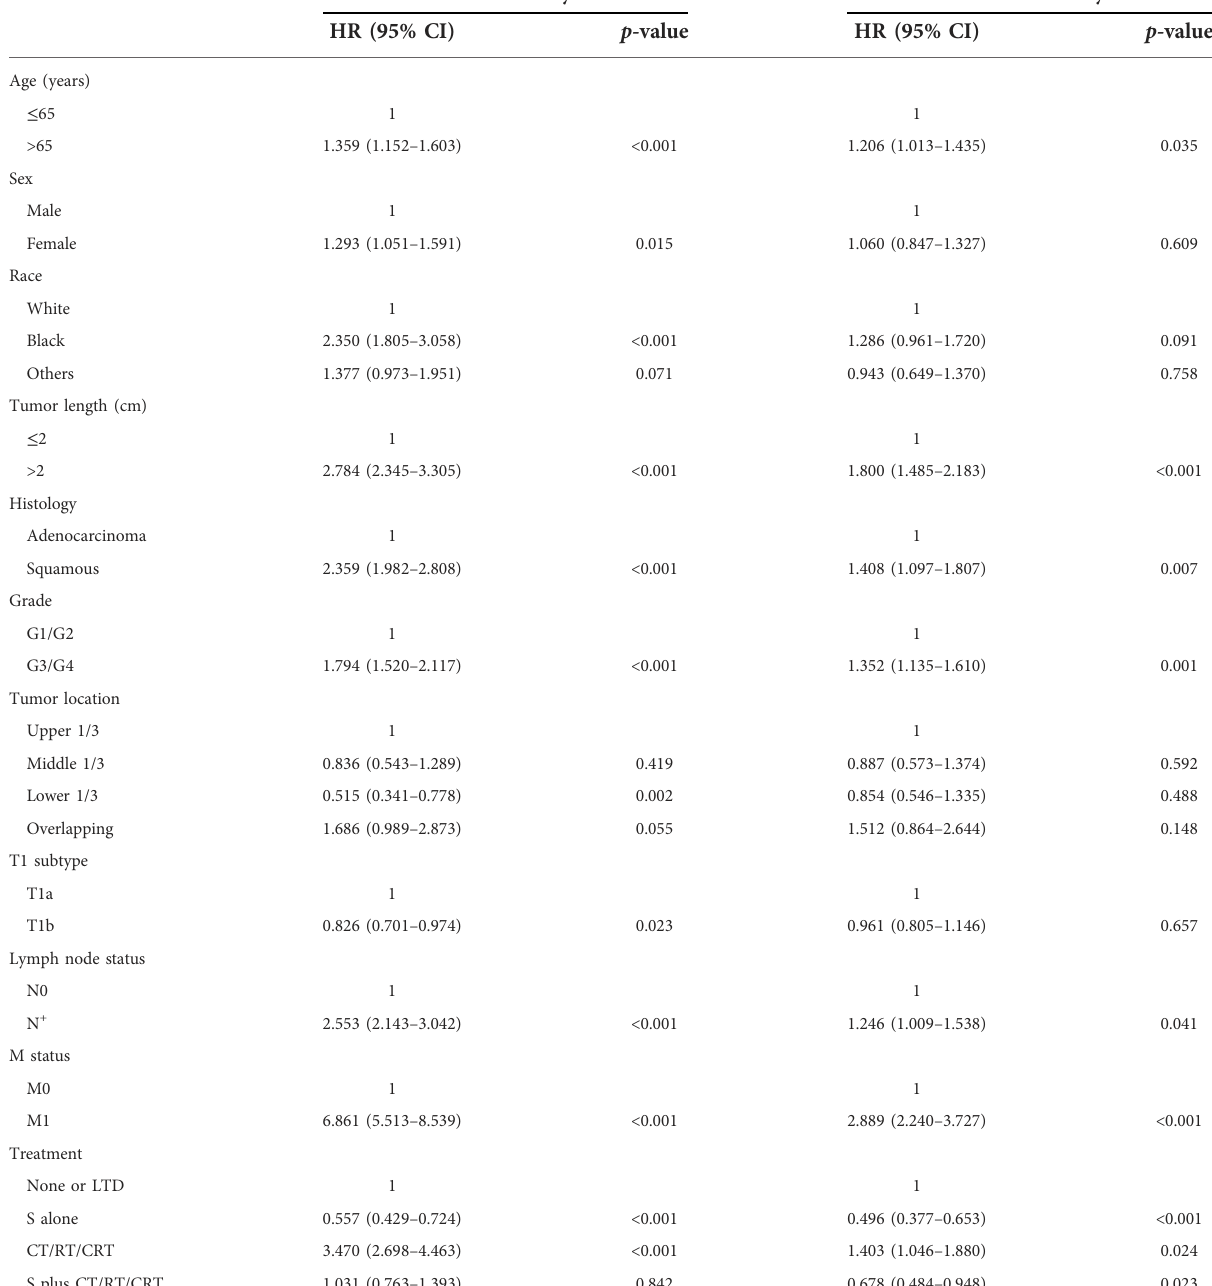
TABLE 4 Cox regression analysis of the risk factors for CSS in patients with survival